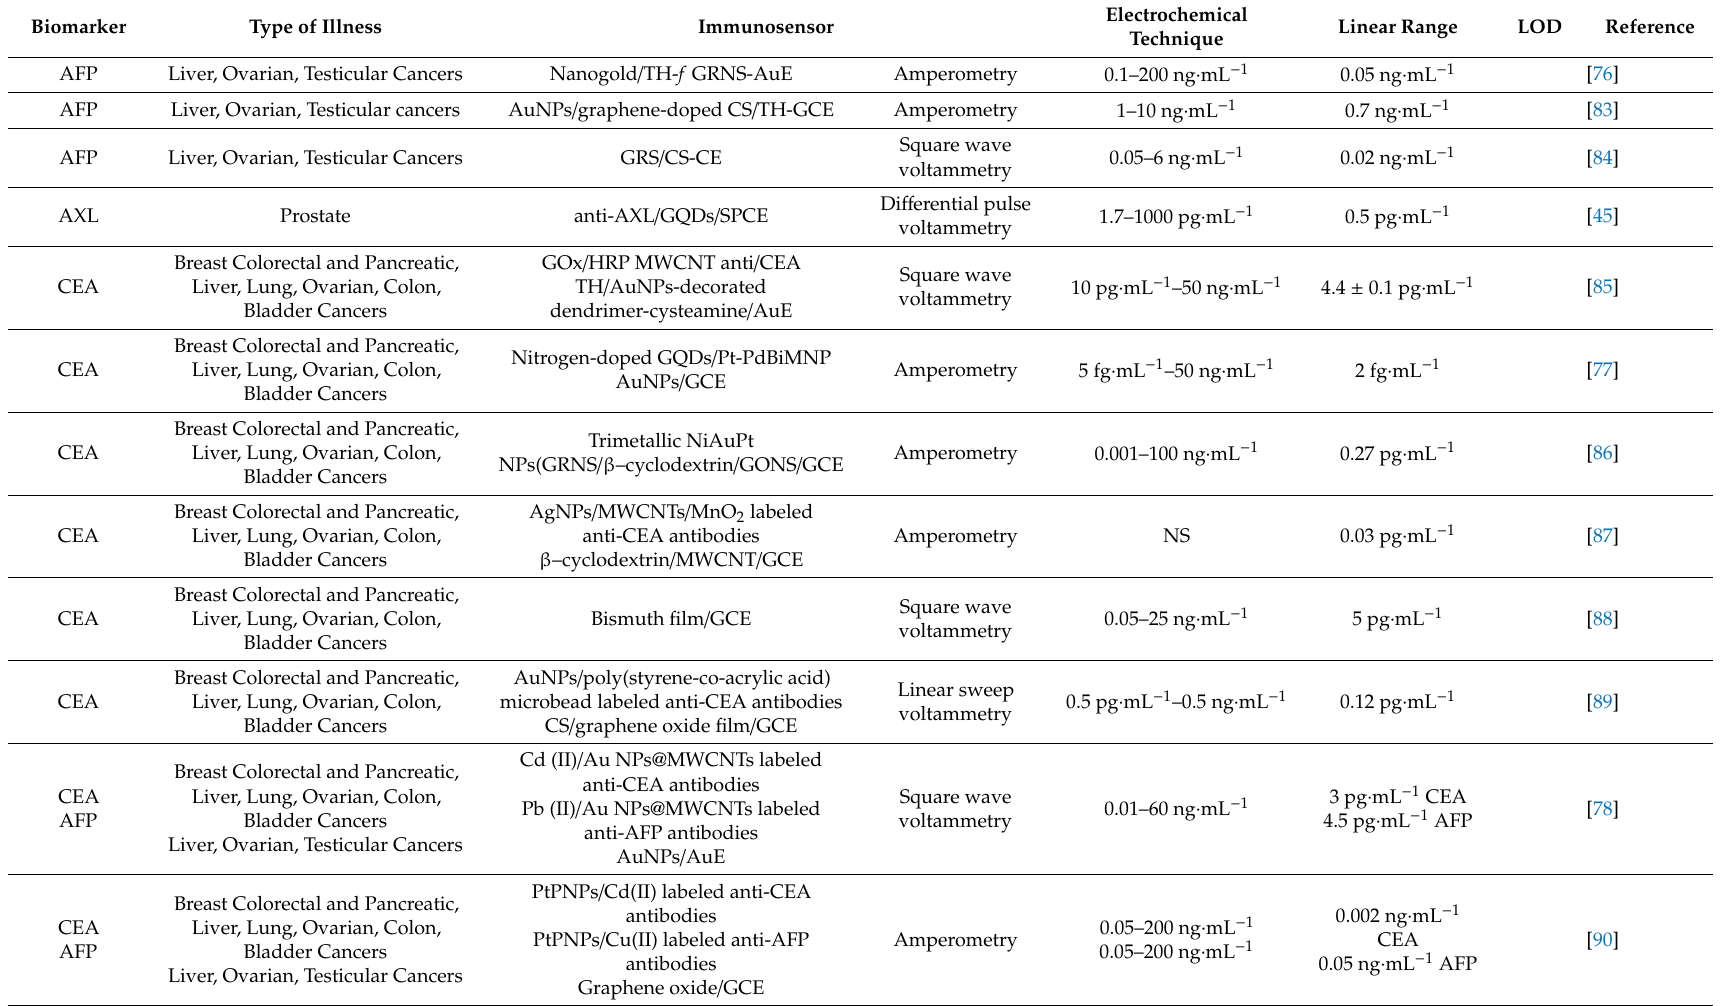
Table 1. Some selected studies on electrochemical immunosensors in clinical